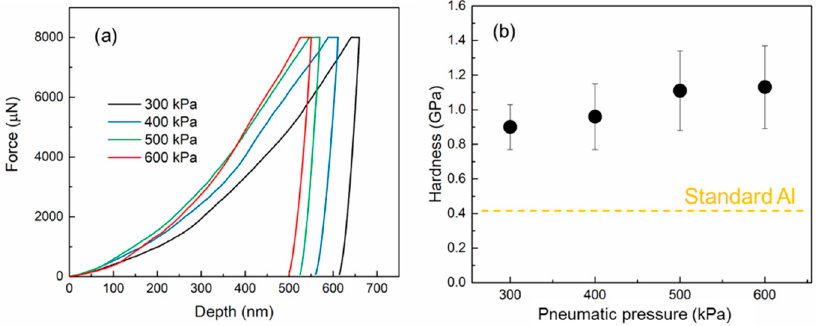
Figure 8. ( a ) Nanoindentation force–depth curves of the sintered and conventional aluminum specimens. ( b ) Hardness value of the aluminum specimens.